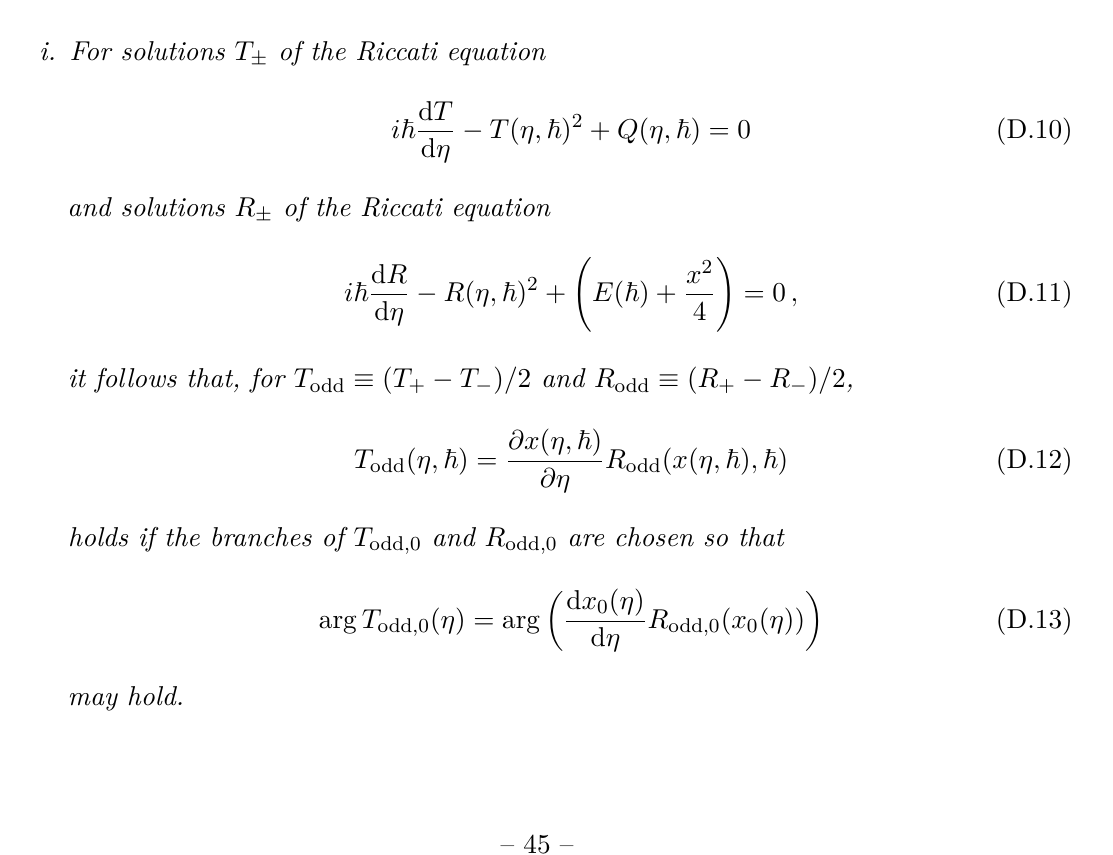
Figure 9 . The integration contour ˇ η → η c → η used in eq. (D.9). The function ω ( η ) is double-valued, with branch cuts (red lines) emanating from the turning points η c and η ∗ sheet (on which ω ( η ) > 0 for real η ), and ˇ η is the point corresponding to η on the “negative” sheet. The integration contour starts from ˇ η on the “negative” sheet, encircles η c , crosses the branch cut, and ends at η on the “positive” sheet. The part of the contour on the “positive” sheet is shown as a solid curve, and the part on the “negative” sheet is shown as a dashed